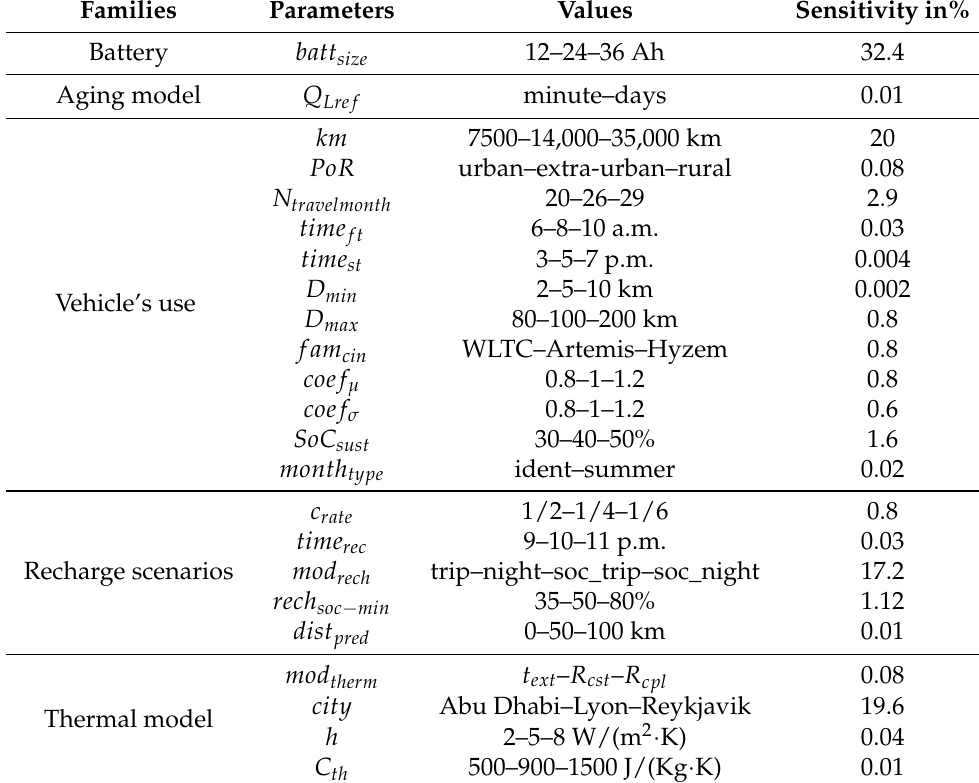
Table 4. Value of the parameter and sensitivity on battery